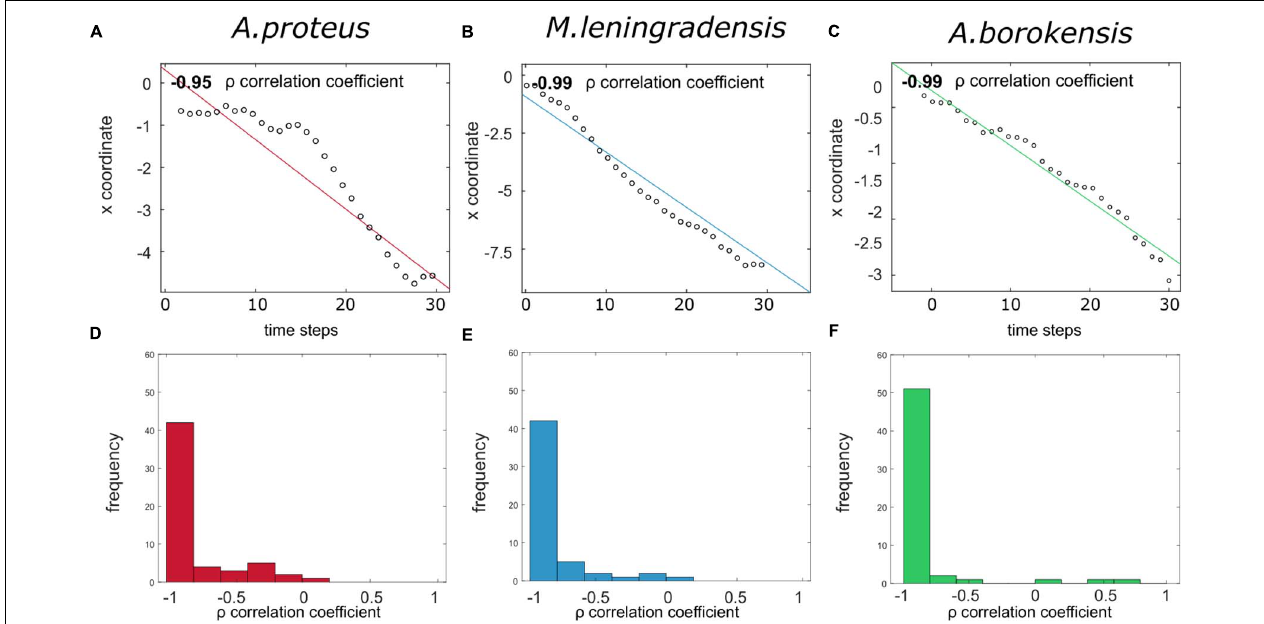
FIGURE 6 | Persistence toward the anode for the cells that acquired conditioned behavior. (A–C) panels illustrate Spearman’s correlation coefficient ρ relating the x coordinate and the time steps for three prototypical cells, each one of them corresponding to one of the species ( A. proteus, M. leningradensis , and A. borokensis ). As it can be observed, there is a strong negative correlation, denoting that as time increases, cells tend to maintain their migratory direction toward the anode, which indicates high persistence during the displacement. (D–F) panels represent histograms for Spearman’s correlation coefficients for the three species, respectively. It can be noticed that the majority of the cells present a strong negative correlation, corresponding to strong persistence toward the